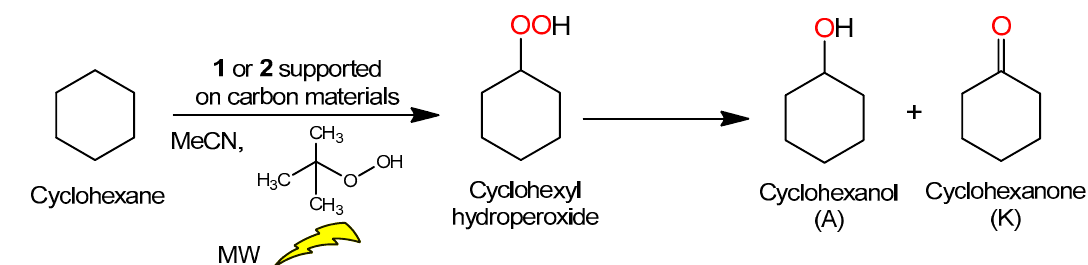
subsequently converted to the alcohol and ketone.